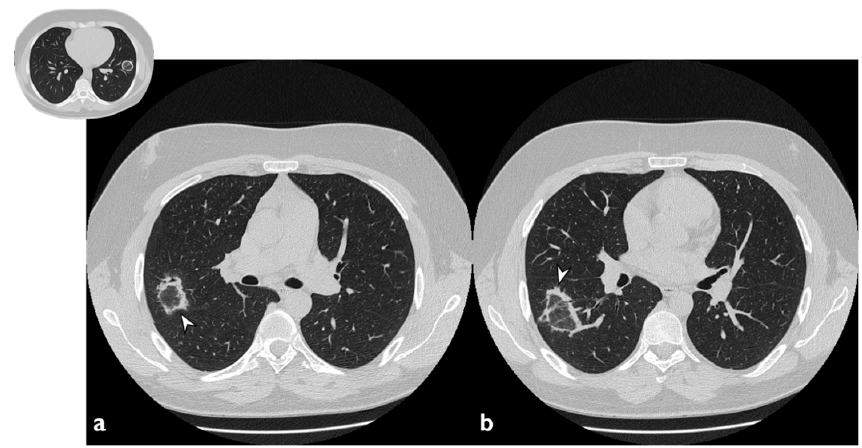
Figure 4. Atoll or reverse halo sign: areas of ground glass opacity surrounded by a ring- or a crescent-shaped consolidation (white arrowheads), which are clearly depicted in the right upper lobe ( a ) and in the right lower lobe ( b ).